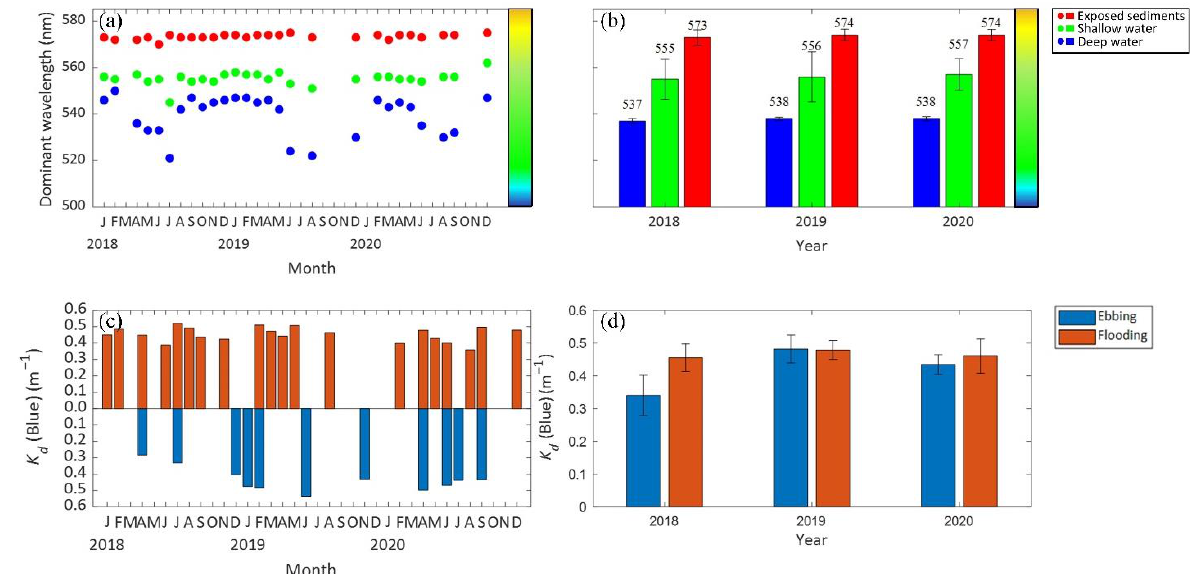
Figure 15. ( a ) The dominant wavelength of deep water, shallow water and exposed sediments in Tauranga Harbour from 2018 to 2020 using the temporal method (applied monthly), with the spatial method used when there were fewer than four images available in a month (with a tile size of 60 m). ( b ) Histograms of the annually averaged dominant wavelength of deep water, shallow water and exposed sediments from 2018 to 2020 in the northern and southern harbours. ( c ) The monthly- resolved K d (Blue) of shallow water from 2018 to 2020, separated by ebbing/flooding (brown/blue) conditions in Tauranga Harbour. ( d ) Histograms of the annually averaged K d Blue measured during ebbing/flooding tides (brown/blue). All panels: Missing values indicate the unavailability of low cloud coverage Sentinel—two images for those